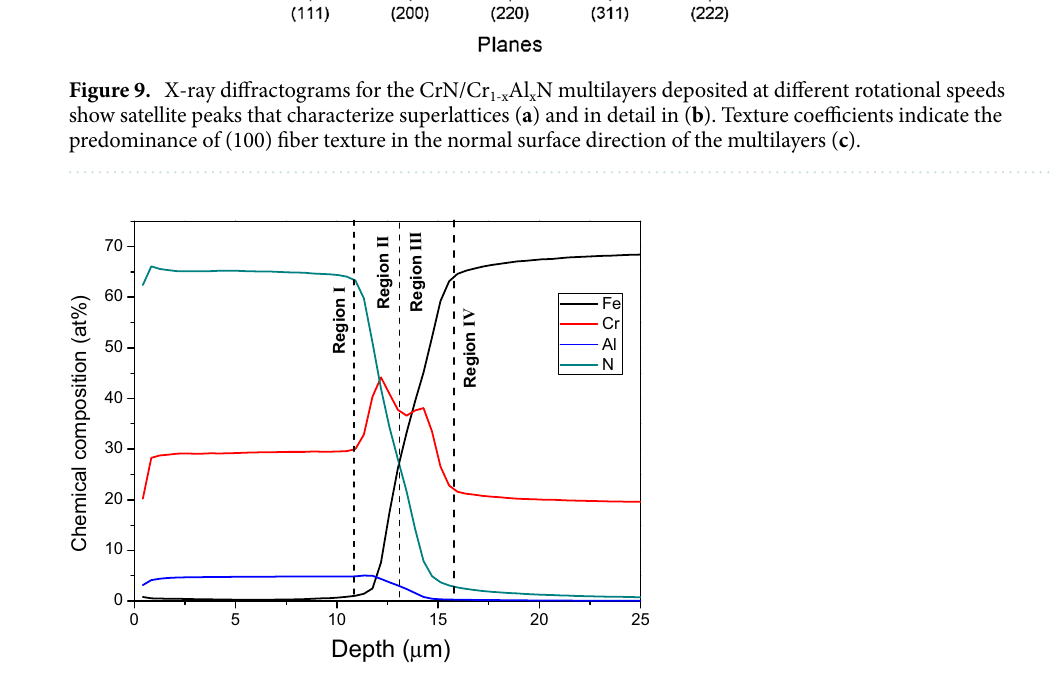
Figure 10. GDOES depth profile of chemical composition across the CrN/Cr 1-x Al x N multilayer and the Cr base layer deposited onto an AISI 304L flat substrate using rotational speed of 1.0 rpm and the bias of − 150